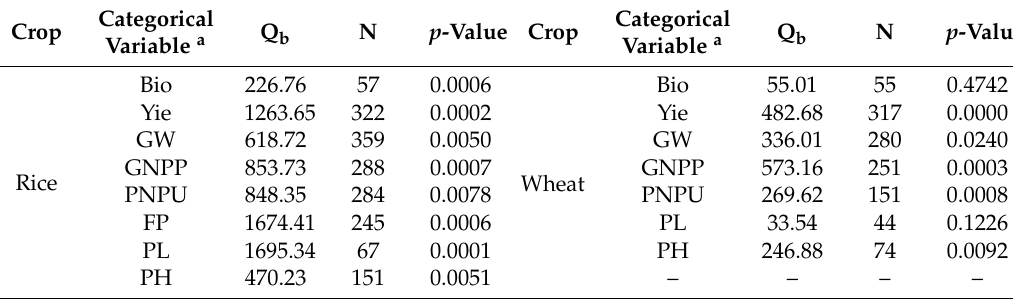
Table 3. Heterogeneity (Q b ) analysis of agronomic traits in rice and